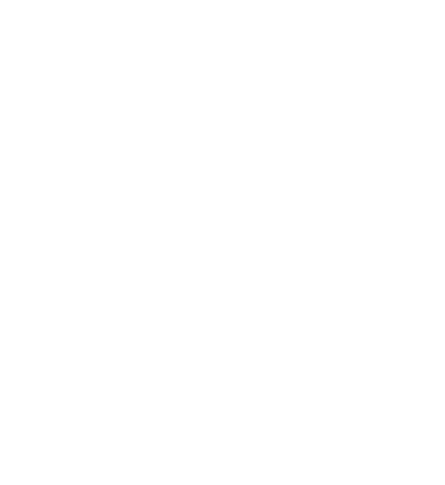
Table 1. Correlations of photosynthetic parameters under different temperatures. Bold indicates a significant correlation between the two indicators. * P < 0.05, ** P <